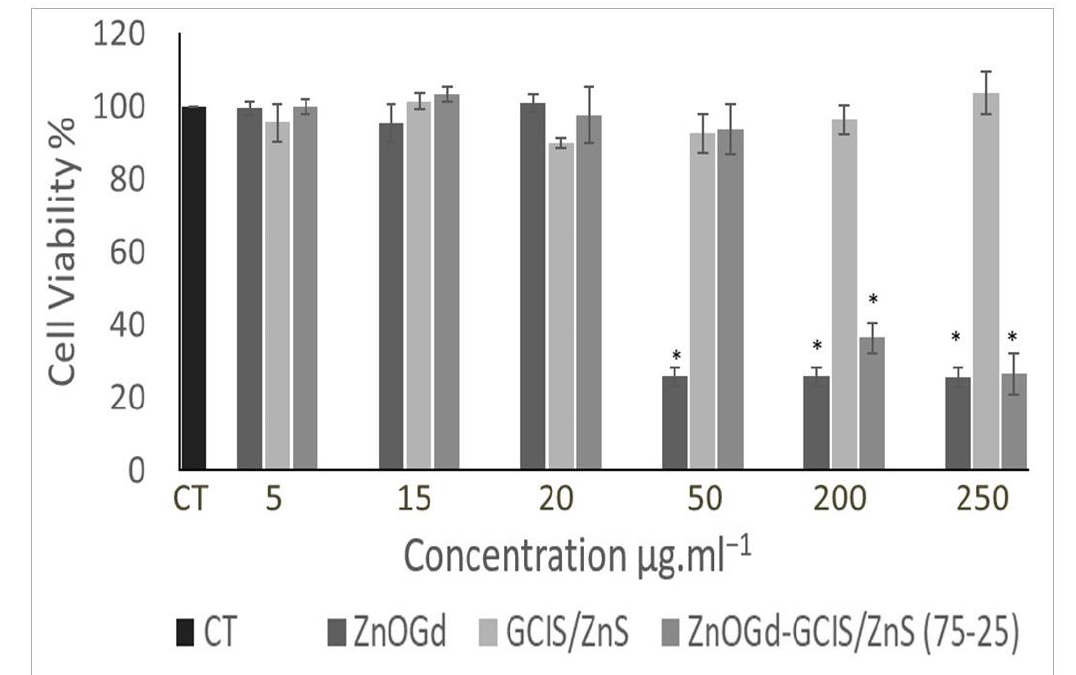
Figure 7. Cytotoxicity of quantum dots modified with GPTMS and dispersed in water (ZnOGd, GCIS/ZnS and ZnOGd-GCIS/ZnS (75-25)) on 3T3/NIH fibroblast cells. Cells were incubated with different concentrations (5, 15, 20, 50, 200 and 250 µ g · mL − 1 ) for 4 h in 5% CO 2 and 37 ◦ C. Data are presented as mean ± standard error of the mean (SEM) of three independent experiments. Statistical significance was determined using the one-way analysis of variance (ANOVA) test followed by the Tukey post-test for multiple comparisons. (CT = control, * p <